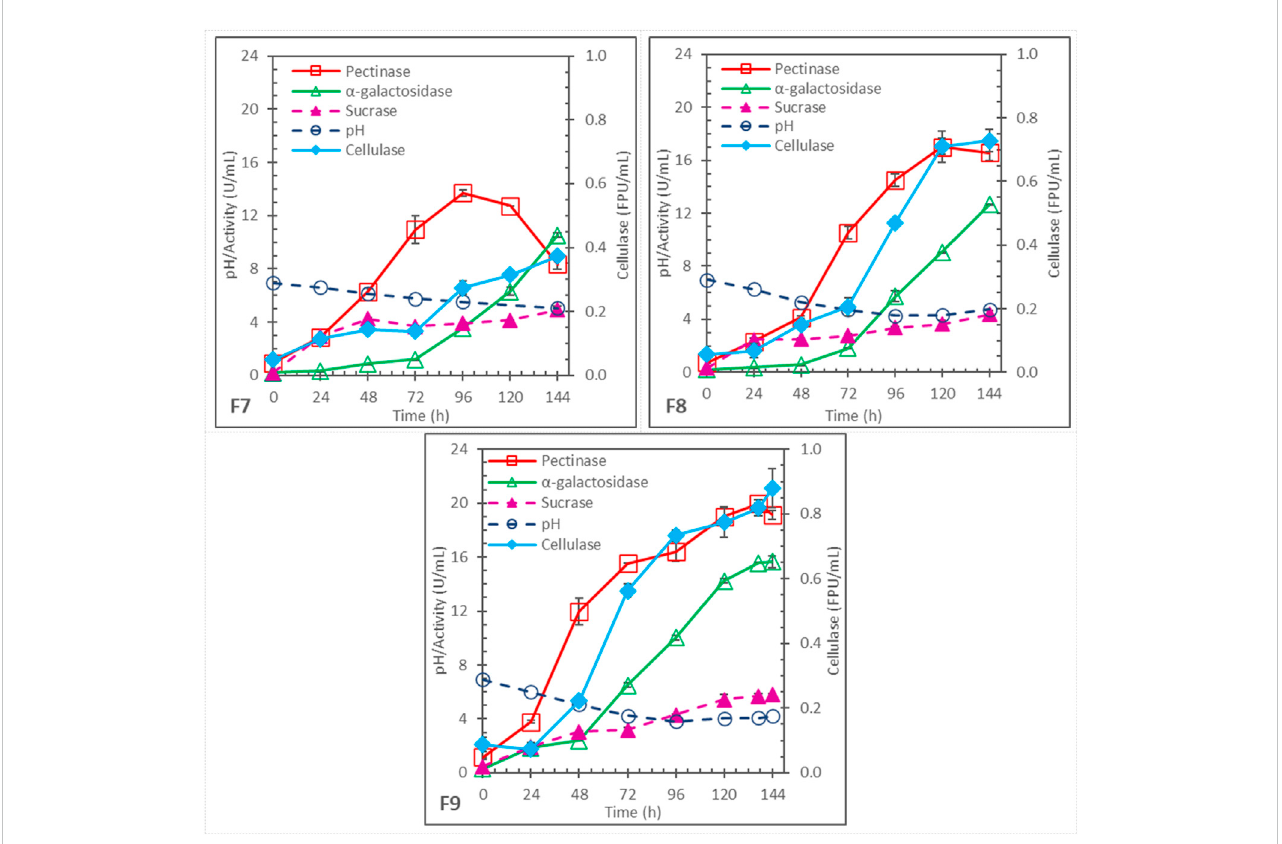
FIGURE 3 Enzyme production in batch fermentations with same initial pH 7, 5x soybean hull, and 2x initial N-sources but with different controlled pH-drop rates anddurations;F7:pH-droprate=.0156/h,topH5.5 at96 h;F8:pH-droprate=.0292/h,topH4.2 at96 h;andF9: pH-droprate=.0357/h,topH4.0 at84 h.